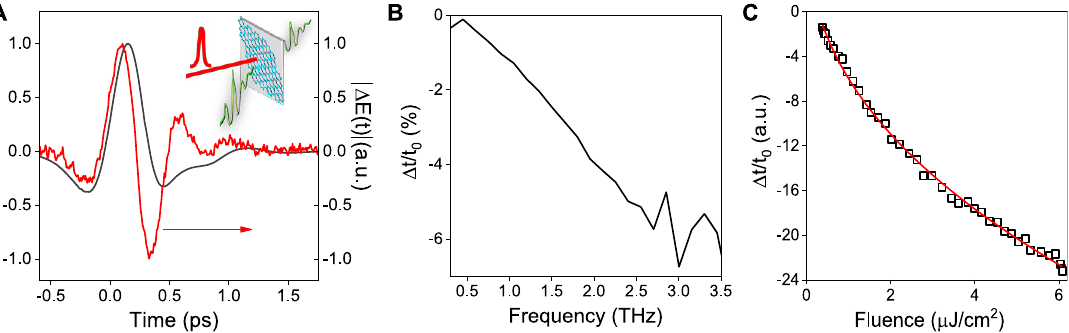
Figure 4: (A) The pulse transmitted through the composite HgTe film E ( t ) (left) and the difference of the THz electric fi eld transmitted through the NCs with and without optical pumping, expressed as | Δ E ( t ) | = | E ON ( t ) − E OFF ( t ) | (right). (B) Amplitude spectrum of the pump-induced change in transmission, Δ t ( ω )/ t 0 ( ω ) for a delay after the optical pump excitation of 2 ps and an incident pump fl uence of 6 μ J cm − 2 . Δ t ( ω ) is the difference of the transmission with and without photoexcitation, Δ t ( ω ) = t ON ( ω ) − t OFF ( ω ). (C) The peak amplitude of Δ t / t 0 as a function of the incident optical pump fl uence from 0.4 μ J cm − 2 to 6 μ J cm − 2 . The red line is a fi t by a square root